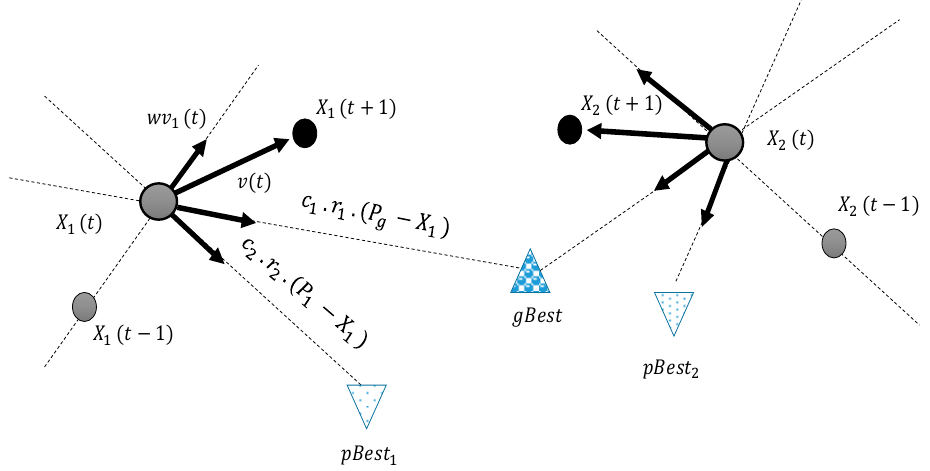
Figure 7. Representation of the fitness function to evaluate particle position and velocity using PSO algorithm.